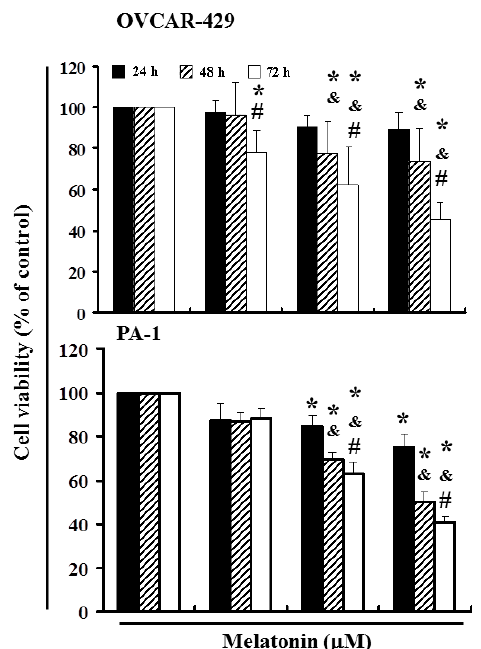
Figure 1. Melatonin mediates the cell viability of ovarian cancer cell lines (OVCAR-429 and PA-1),